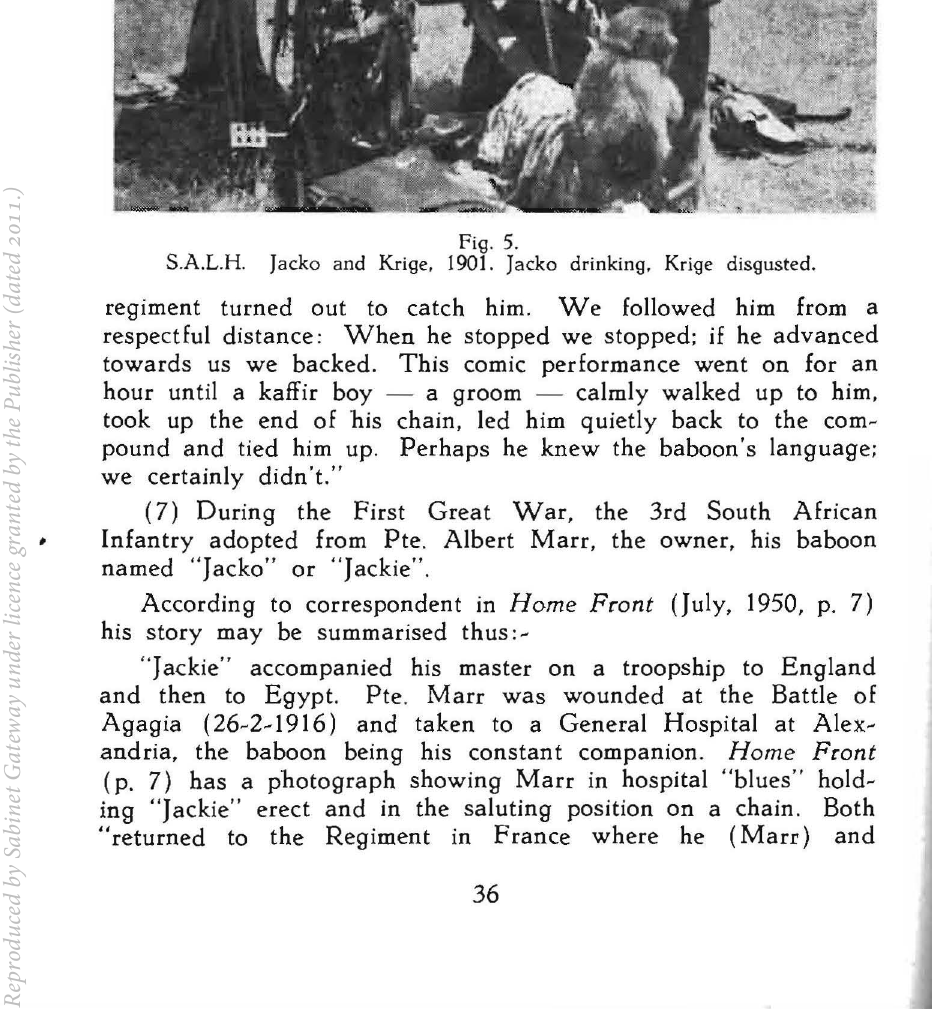
Fig. 5. S.A.L.H. Jacko and Krige, 1901. Jacko drinking. Krige